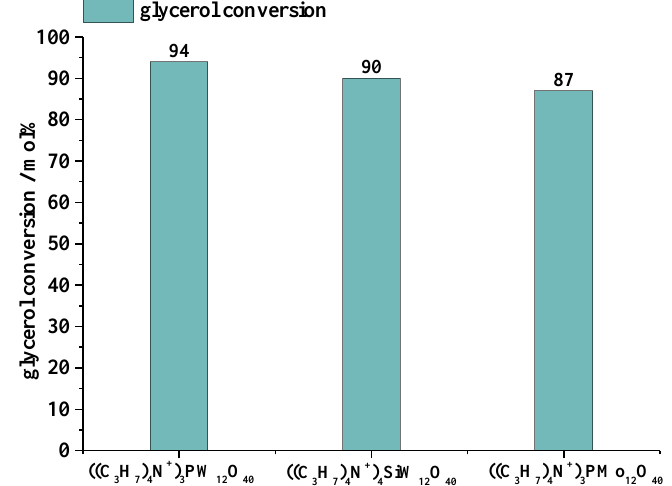
Figure 26. Impact of the Keggin anion on the catalytic activity of organic – inorganic heteropoly salts in carbonation reactions of glycerol with urea (adapted from ref. [71]). in carbonation reactions of glycerol with urea (adapted from ref. [71]).